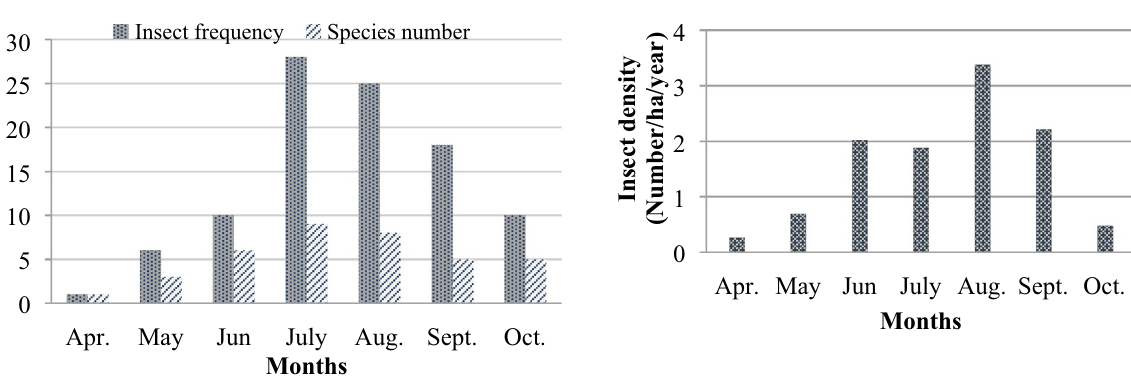
Figure 4. Total insect frequency, species number and insect density changes of Buprestidae family insects depending on months for 2015–2016